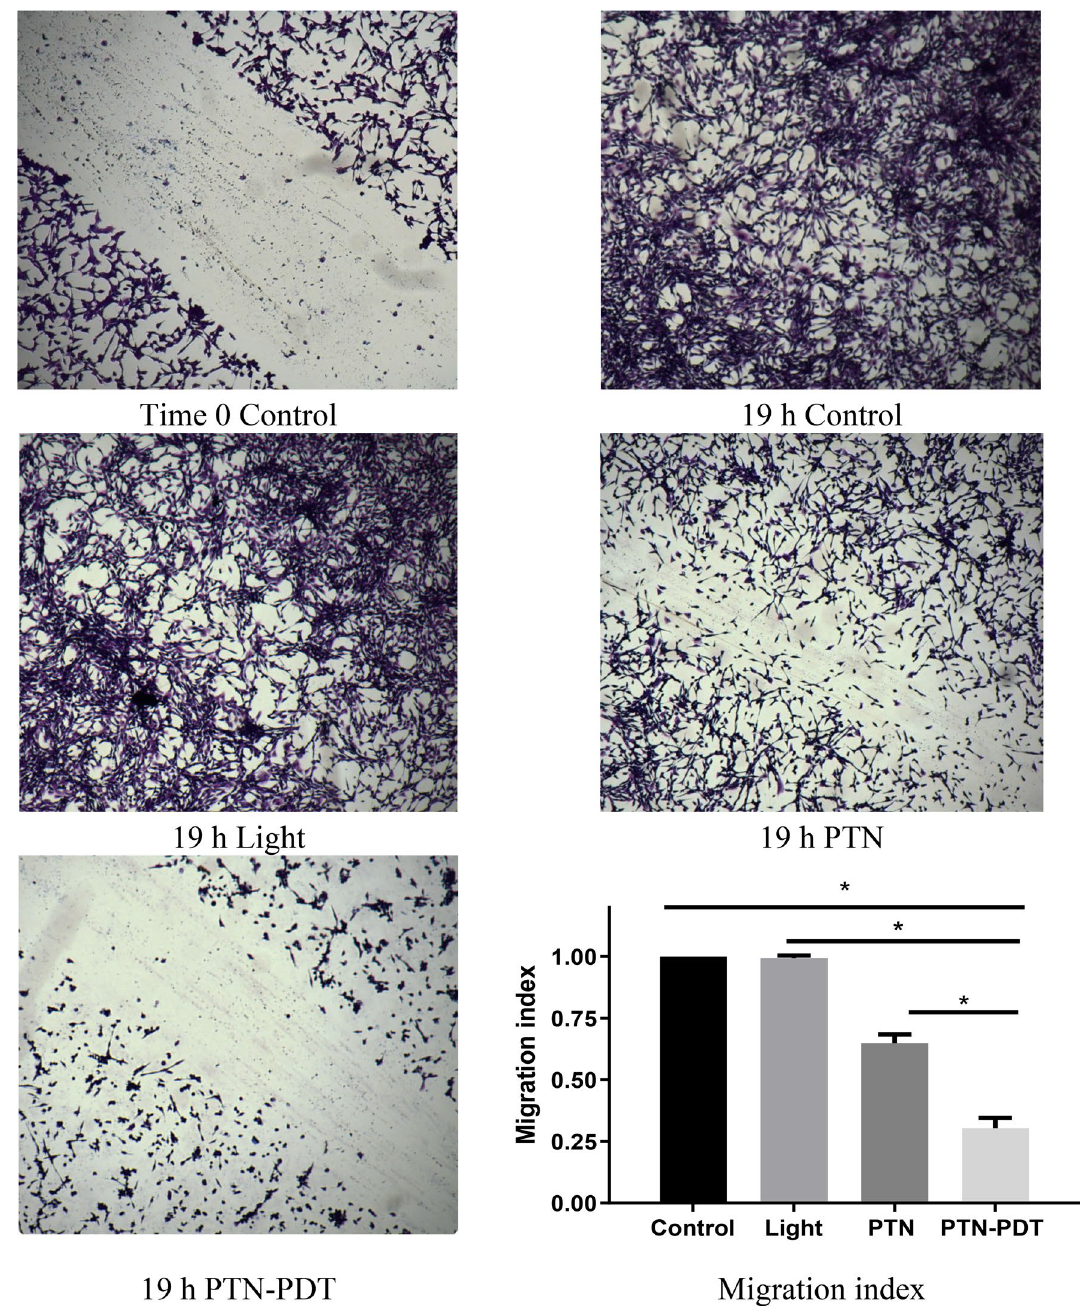
Figure 4. Impact of PTN-PDT on cell migration. LM2 cells were exposed 1 h to 30 µM PTN and immediately after 1.78 J/cm 2 illuminations, they were wounded. Cell migration was documented after overnight incubation (19 h). Representative images processed using image processing software (Fiji ImageJ 2.0.0-rc61/1.51n) are shown: control cells at time 0 before migration (MI = 0), control cells treated with the vehicle at 19 h (MI = 1), illumination and PTN controls at 19 h and PTN-PDT at 19 h. Migration indexes were calculated. *p < 0.0001, ANOVA test followed by Tukey’s multiple comparisons